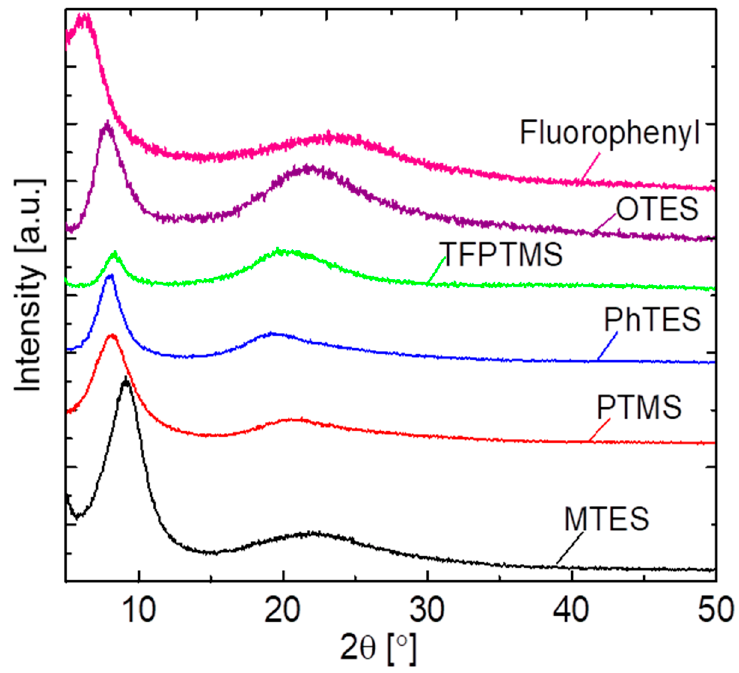
Figure 2. XRD patterns of various pendant–type silica–derived gels calcined at 300 °C under a N 2 atmosphere.